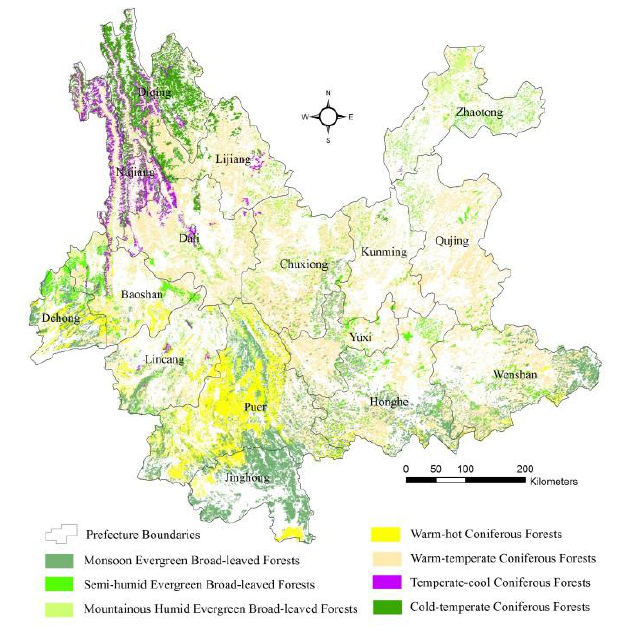
Figure 1. The distribution of forest vegetation in Yunnan Province in the 2010s.